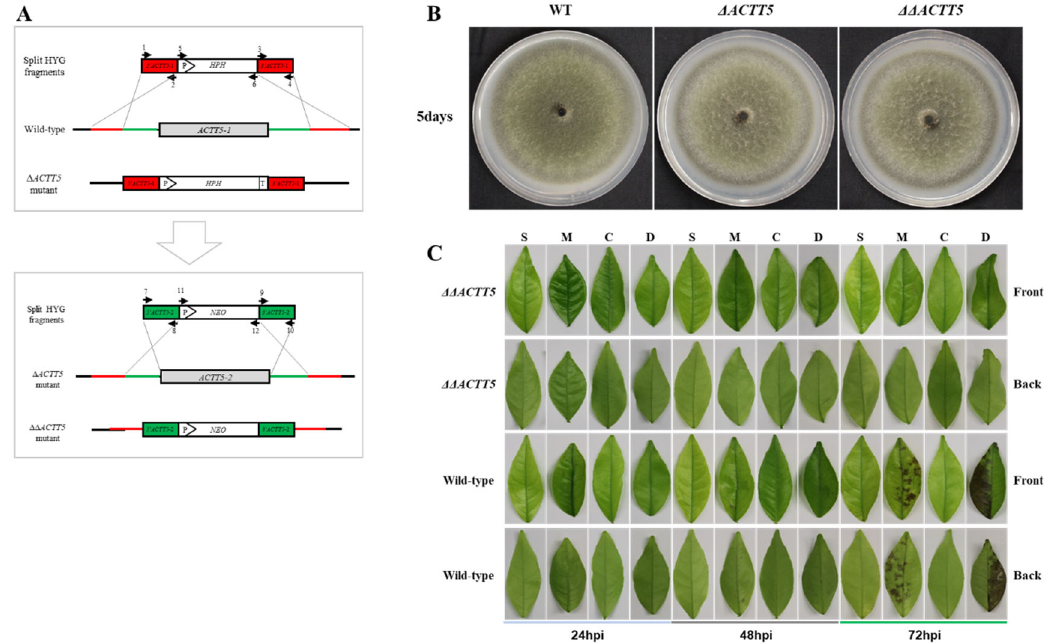
Figure 2. ACTT5 knockout and virulence assay. ( A ) Schematic diagram for ACTT5 knockout. ( B ) ACTT5 was not involved in vegetative growth. ( C ) ACTT5 was required for virulence. “S” means